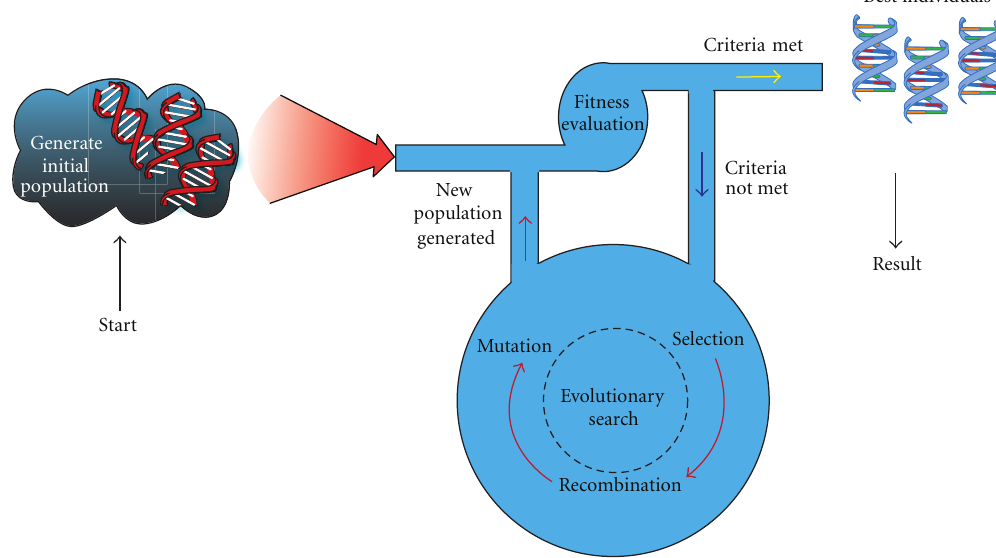
Figure 1: Evolutionary